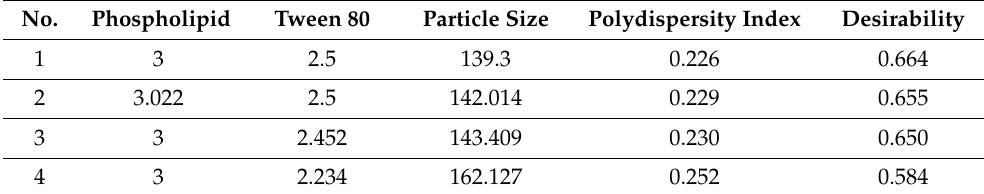
Table 3. Desirability Value Based on Expert